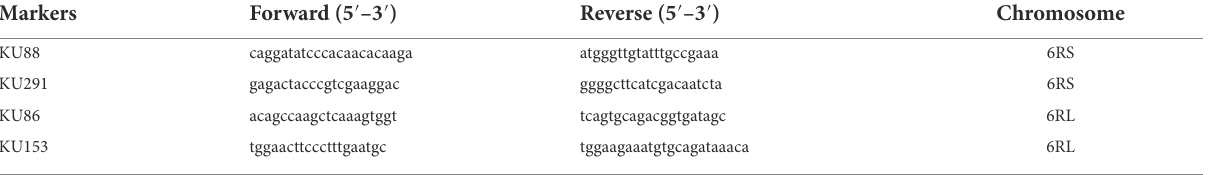
TABLE 2 The sequences of the specific molecular markers for PCR used in this